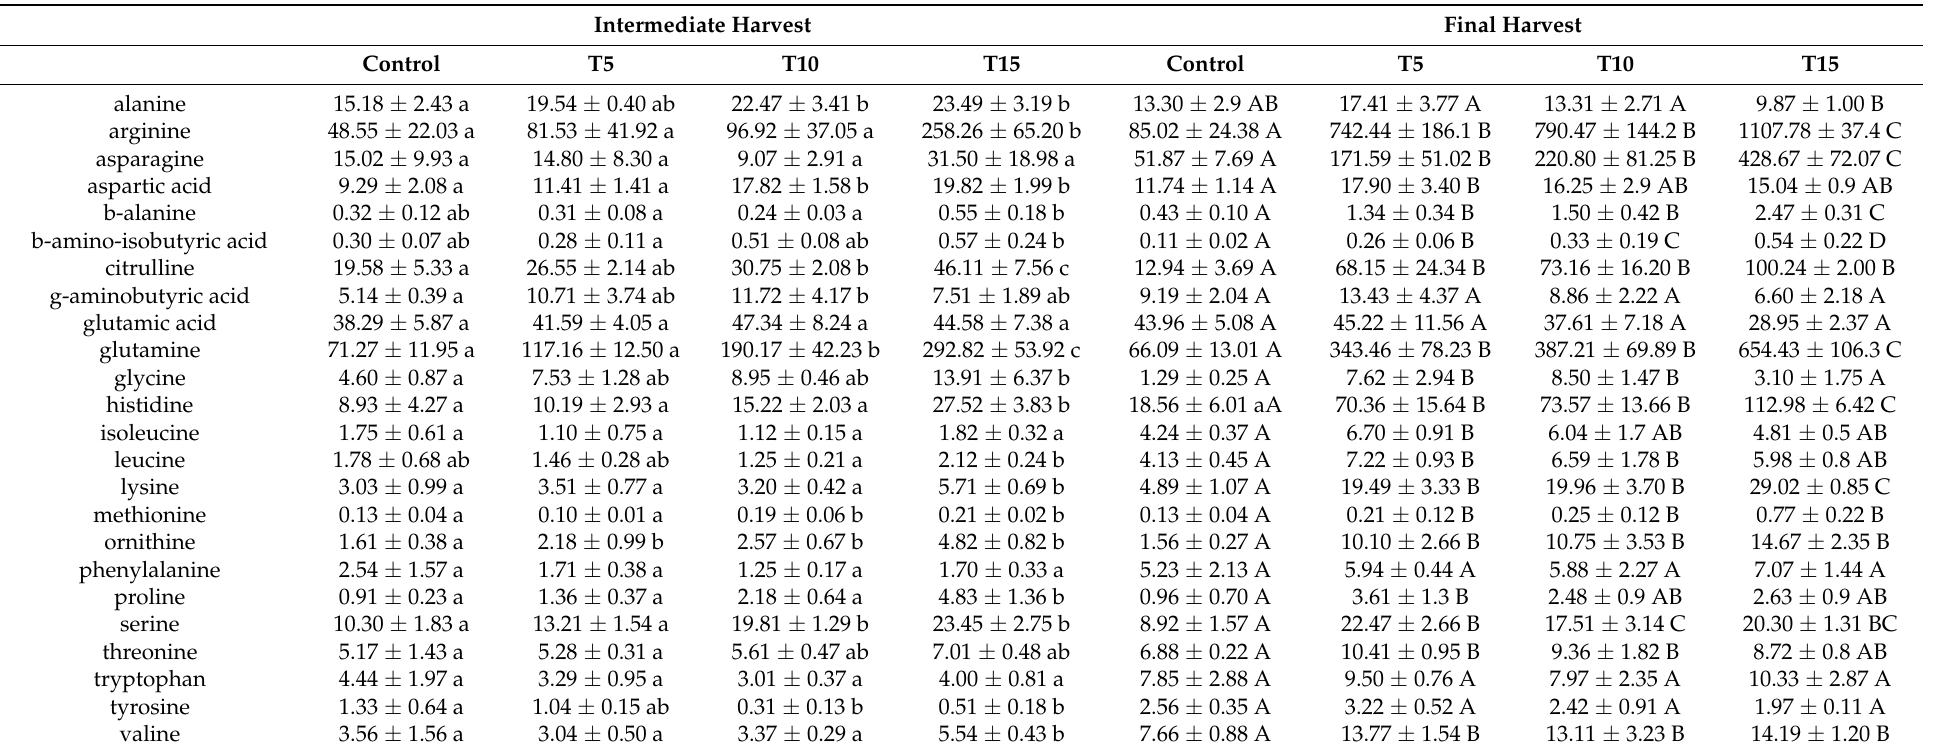
Table 2. Individual amino acid concentration in basil leaves for the various salinity treatments at the intermediate and final harvests, expressed as mg kg − 1 FW. Values in all layers are expressed as mean ± standard deviation ( n = 5). Different letters indicate statistically significant differences between treatments at each harvest (small letters refer to the intermediate and capital ones to the final harvest, p <